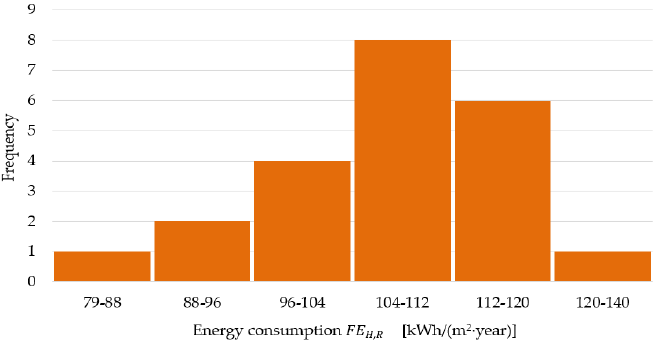
Figure 6. Structure of buildings by size of heating energy demand index before thermal improvement FE H , R [kWh/(m 2 ·